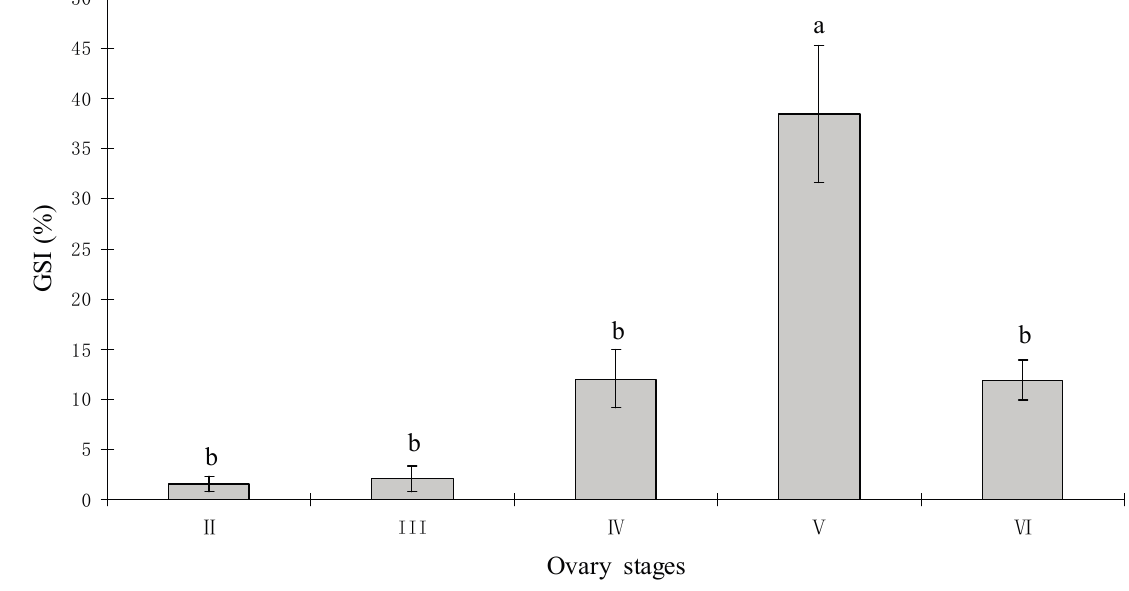
Figure 2. Changes of the Gonadosomatic Index (GSI) values at different ovary stages in C. semilaevis ( n = 4) . Each bar represents the mean ± standard error (SE). The values with different letters differ significantly from each other ( p <